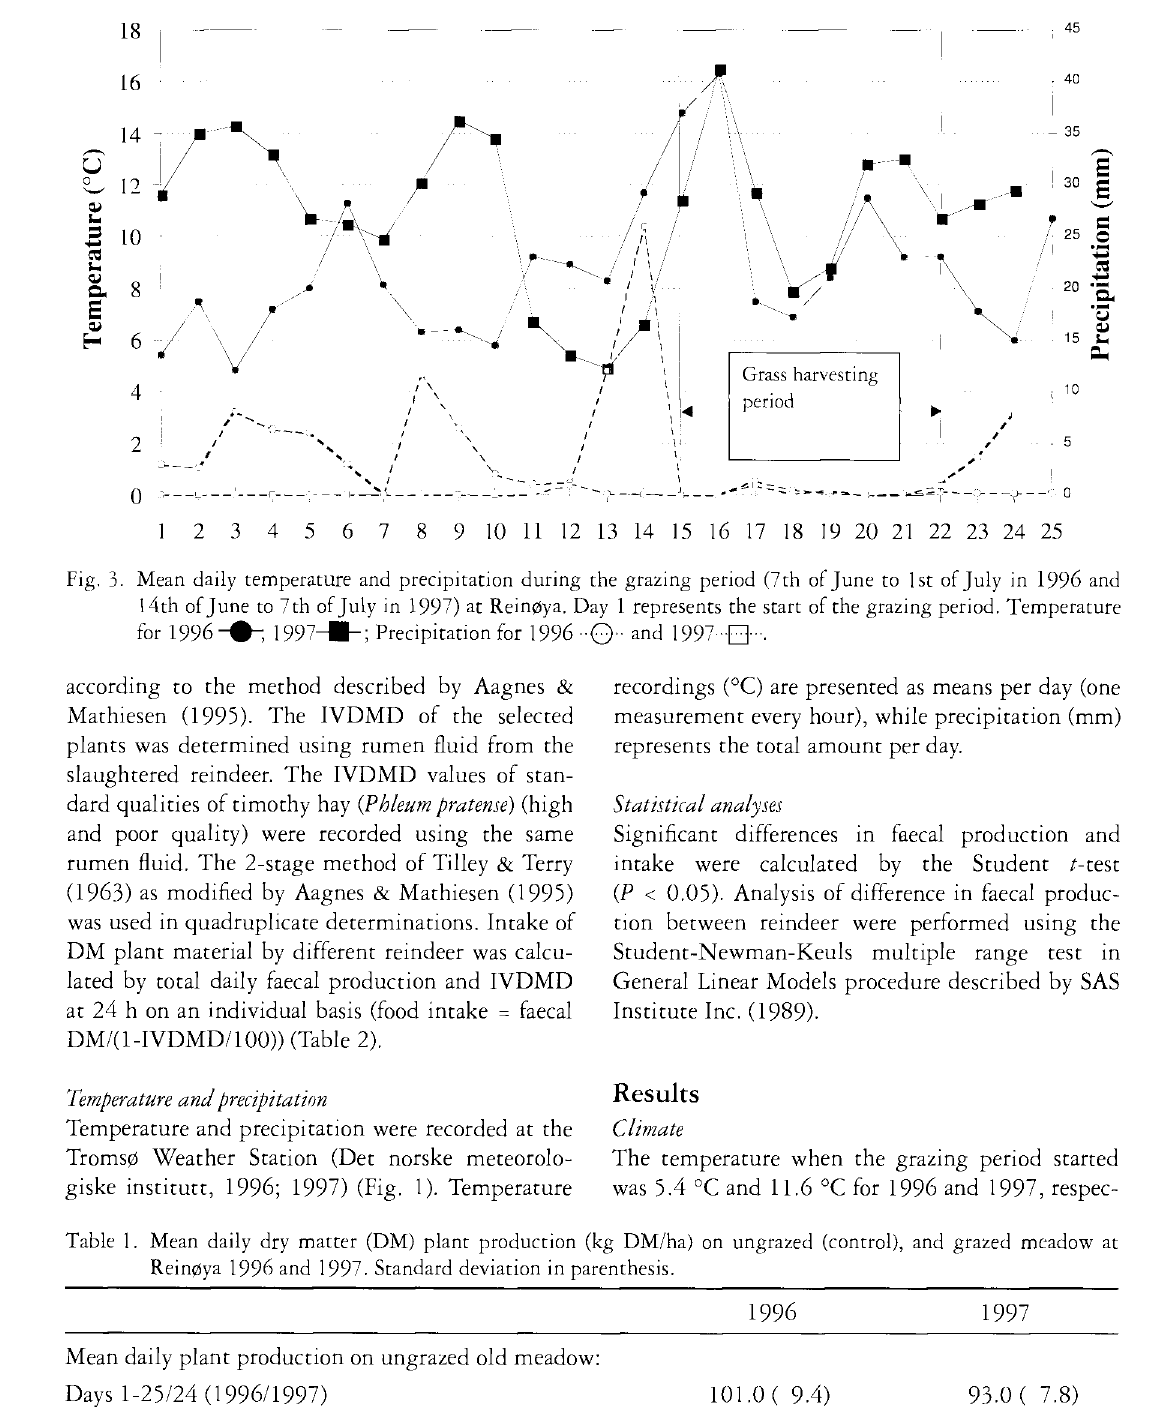
Table 1. Mean daily dry matter (DM) plant production (kg DM/ha) on ungrazed (control), and grazed meadow at Reinøya 1996 and 1997. Standard deviation in